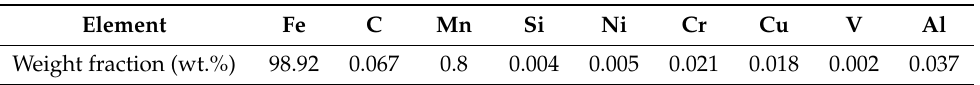
Table 1. Chemical composition of the P355NL1 steel, determined using glow-discharge optical emission spectroscopy. Element